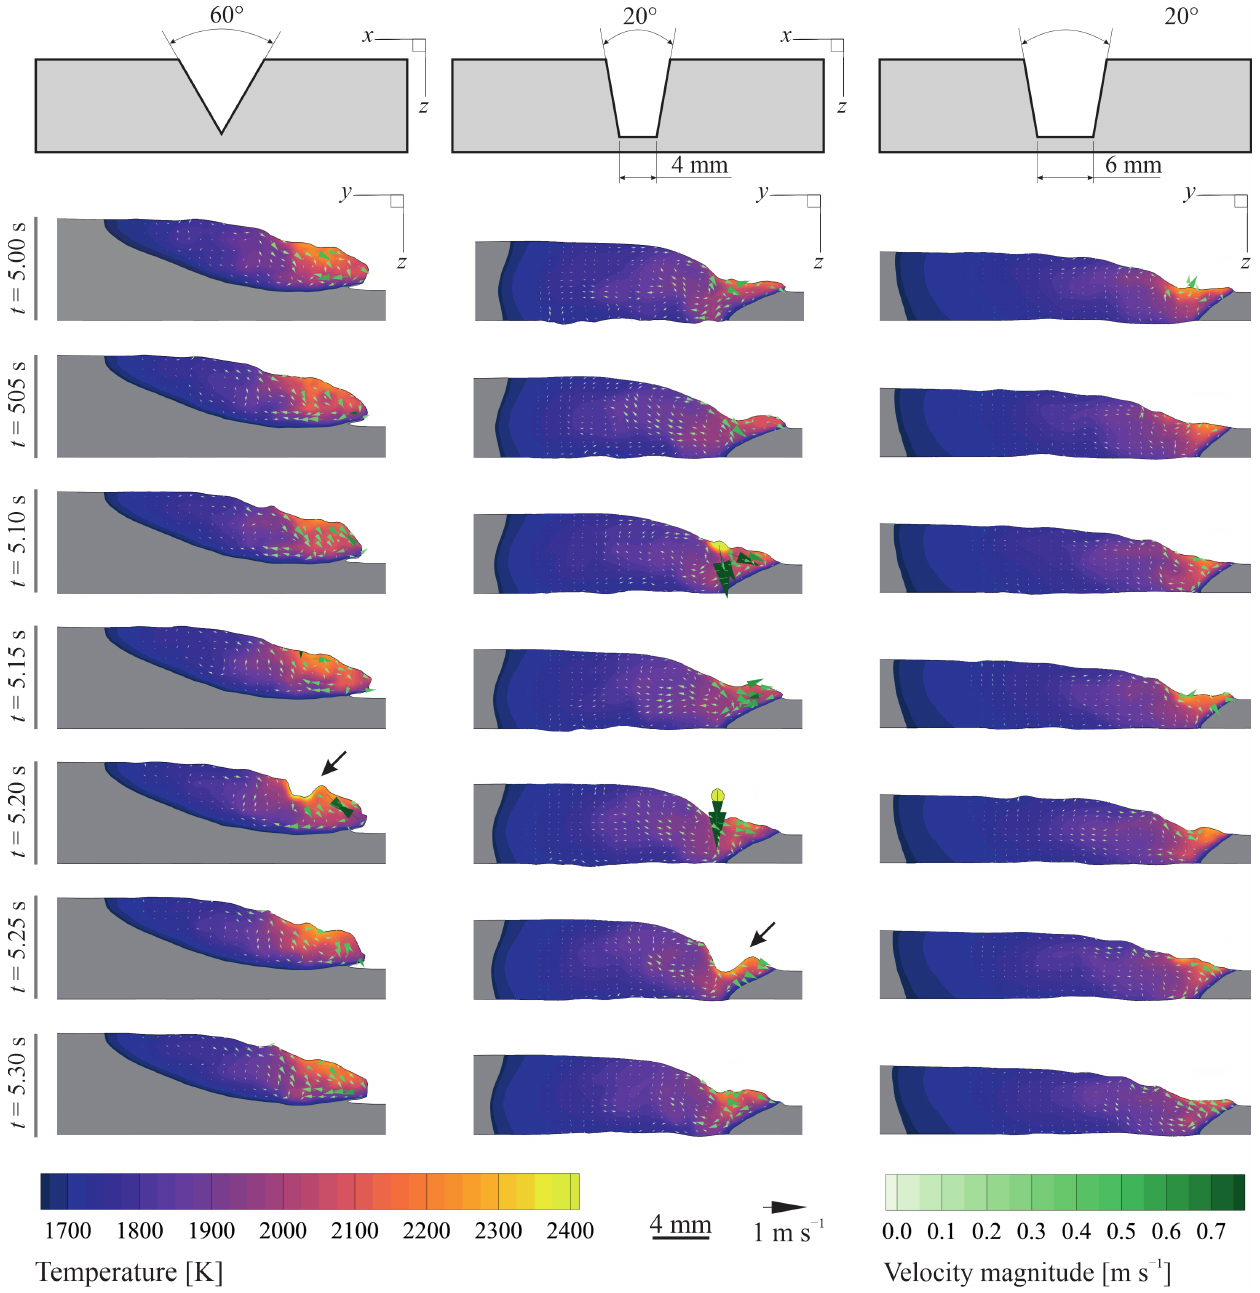
Figure 6. Melt-pool shape, temperature profile and velocity vectors in the x = 0 plane for different joint shapes and time instances. (left column) groove angle θ = 60 ◦ and no root-leg ( W r = 0mm), (middle column) θ = 20 ◦ and root-leg width W r = 4mm and (right column) θ = 20 ◦ and root-leg width W r = 6mm. Wire feed rate u w = 7mmin − 1 , welding current I = 220A, and travel speed V = 7.5ms − 1